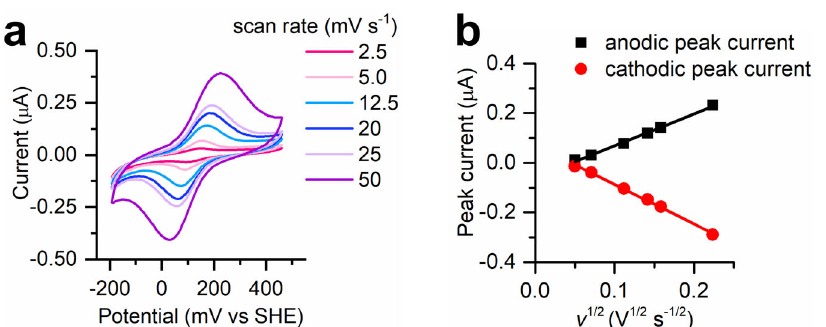
Fig.6|FeMETPsc1electrochemicalcharacterization.a Cyclicvoltammogramsof FeMETPsc1 (80 μ M) recorded at different scanning rate from 2.5 to 50mV s − 1 (bright pink to violet), in 40mM HEPES buffer (pH 7) and 0.3M KCl. Each vol- tammogram is the last of three consecutive scans. b Anodic and cathodic peak currents derived from cyclic voltammetry experiments of FeMETPsc1 (80 µ M)